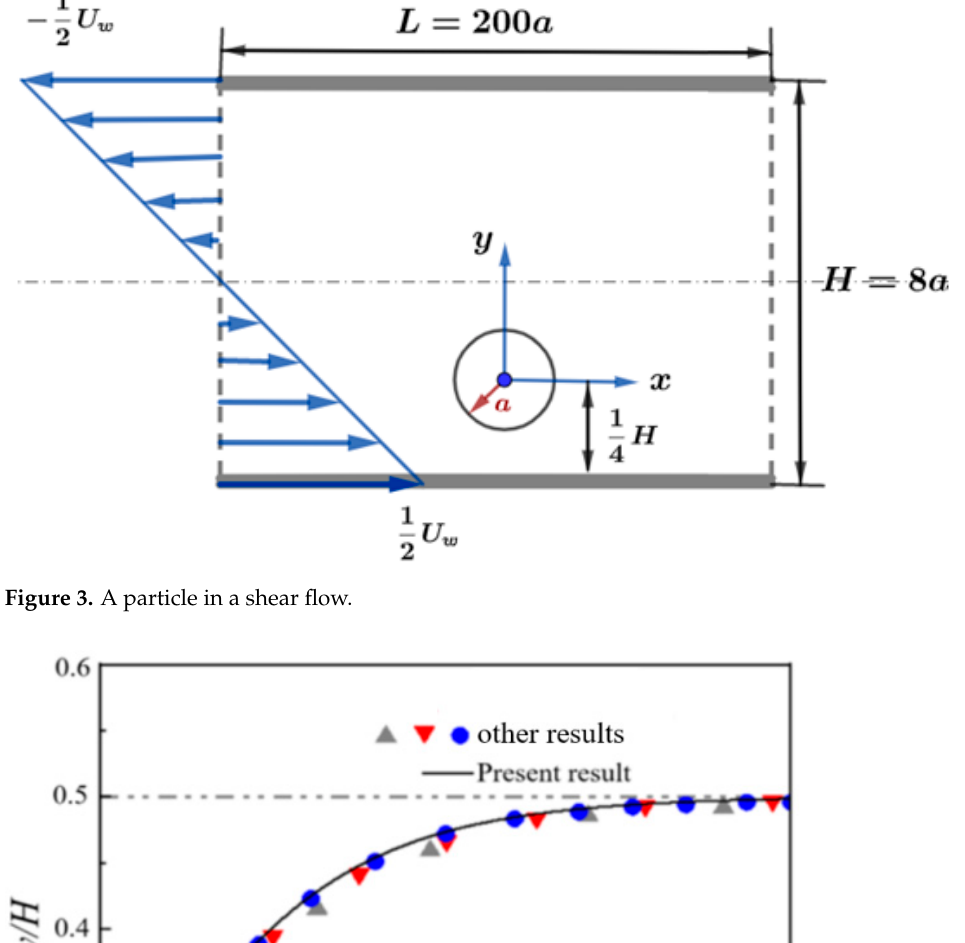
Figure 4. Comparison of trajectory in a shear